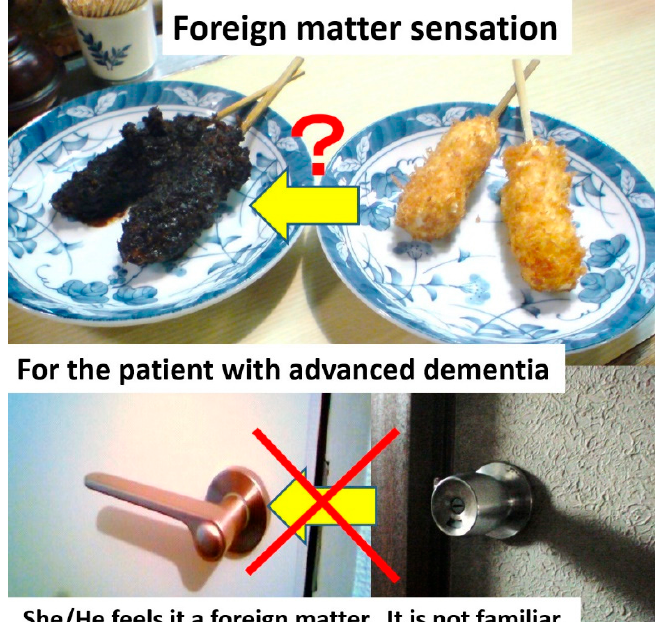
Figure 12. Confusing changes for patients with dementia.